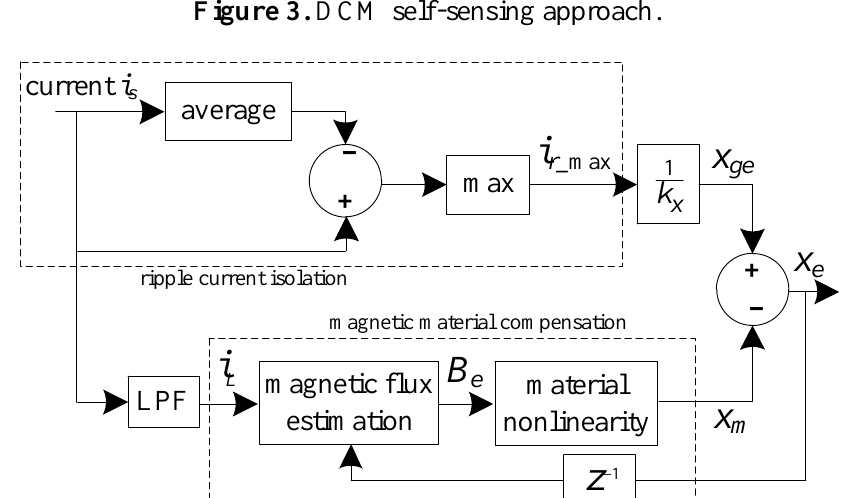
Figure 3. DCM self-sensing approach.